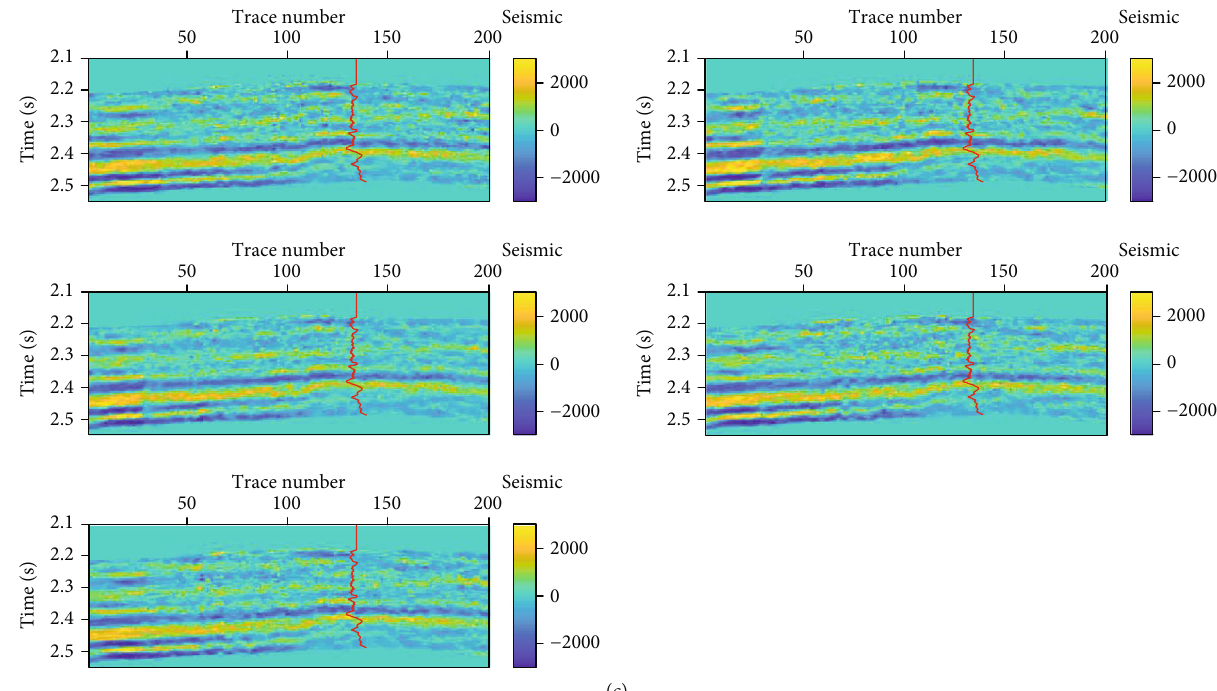
Figure 10: Partially incidence-angle-stacked seismic data with fi ve azimuths, where (a) is the near-angle seismic data, (b) is the middle-angle seismic data, and (c) is the far-angle seismic data. Note that the fi ve azimuths are 20 ° (ranged from 0 ° to 40 ° ), 55 ° (ranged from 35 ° to 75 ° ), 90 ° (ranged from 70 ° to 110 ° ), 125 ° (ranged from 105 ° to 145 ° ), and 160 ° (ranged from 140 ° to 180 ° ),